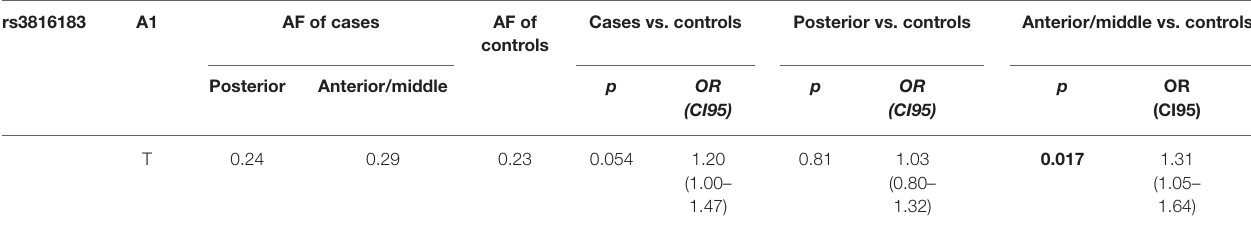
TABLE 2 | Stratification analysis to evaluate the association between HAAO rs3816183 T > C polymorphism and hypospadias susceptibility (by subgroup). rs3816183 AF of cases AF of Cases vs. controls Posterior vs. controls Anterior/middle vs. controls